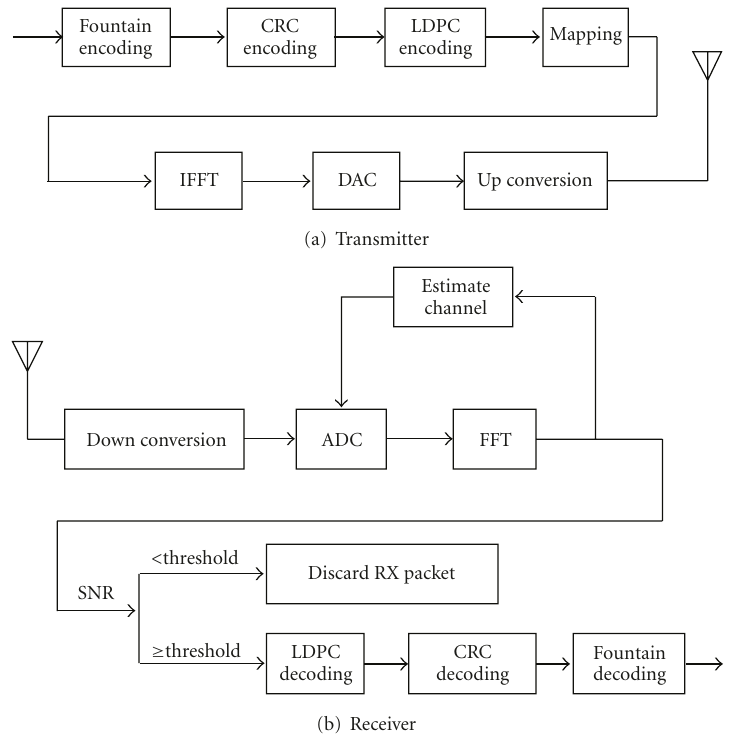
Figure 5: Proposed 802.11a (a) transmitter and (b) receiver. In the transmitter, first source packets are encoded by Fountain codes then LDPC and CRC are applied to each Fountain-encoded packet; after that each encoded packet is transmitted over a subcarrier. In the receiver, the channel is first estimated by high-resolution ADCs then the resolution of ADCs are adapted to the minimum according to the estimated channel knowledge. Each received packet is decoded by LDPC and CRC if SNR ≥ threshold, otherwise, it will be discarded. When the receiver gets N Fountain-encoded packets, it can recover the source